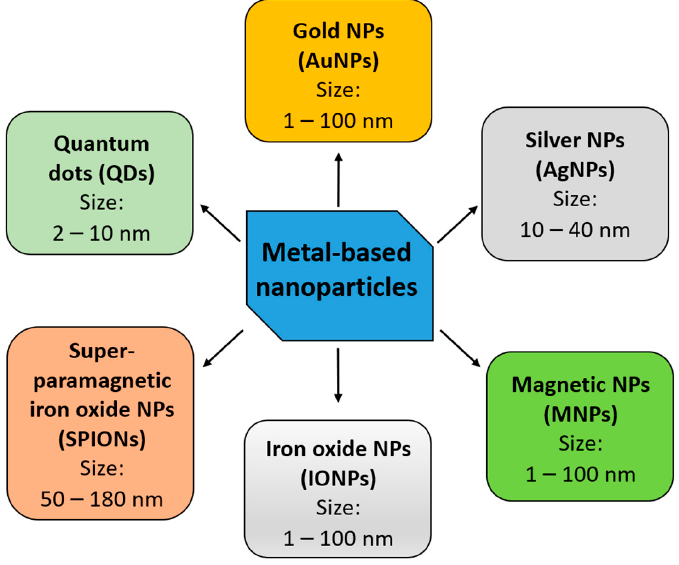
Figure 2. The major categories of metal-based nanoparticles currently studied for application in GBM therapy. NPs—nanoparticles.